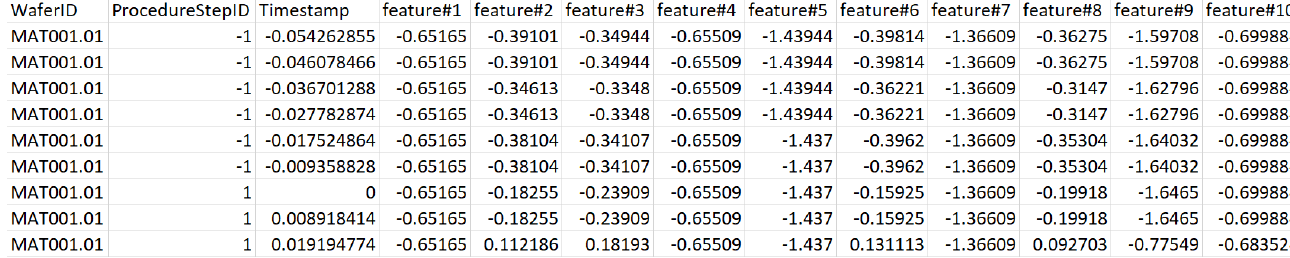
Figure A1. Dataset masking and anonymization: some sample